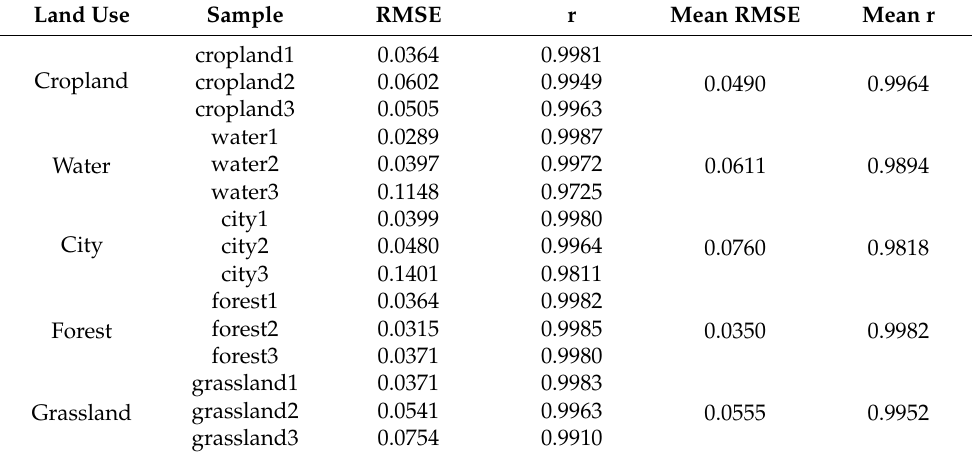
Table 3. RMSE and r values of the Landsat 8 OLI images before and after cloud